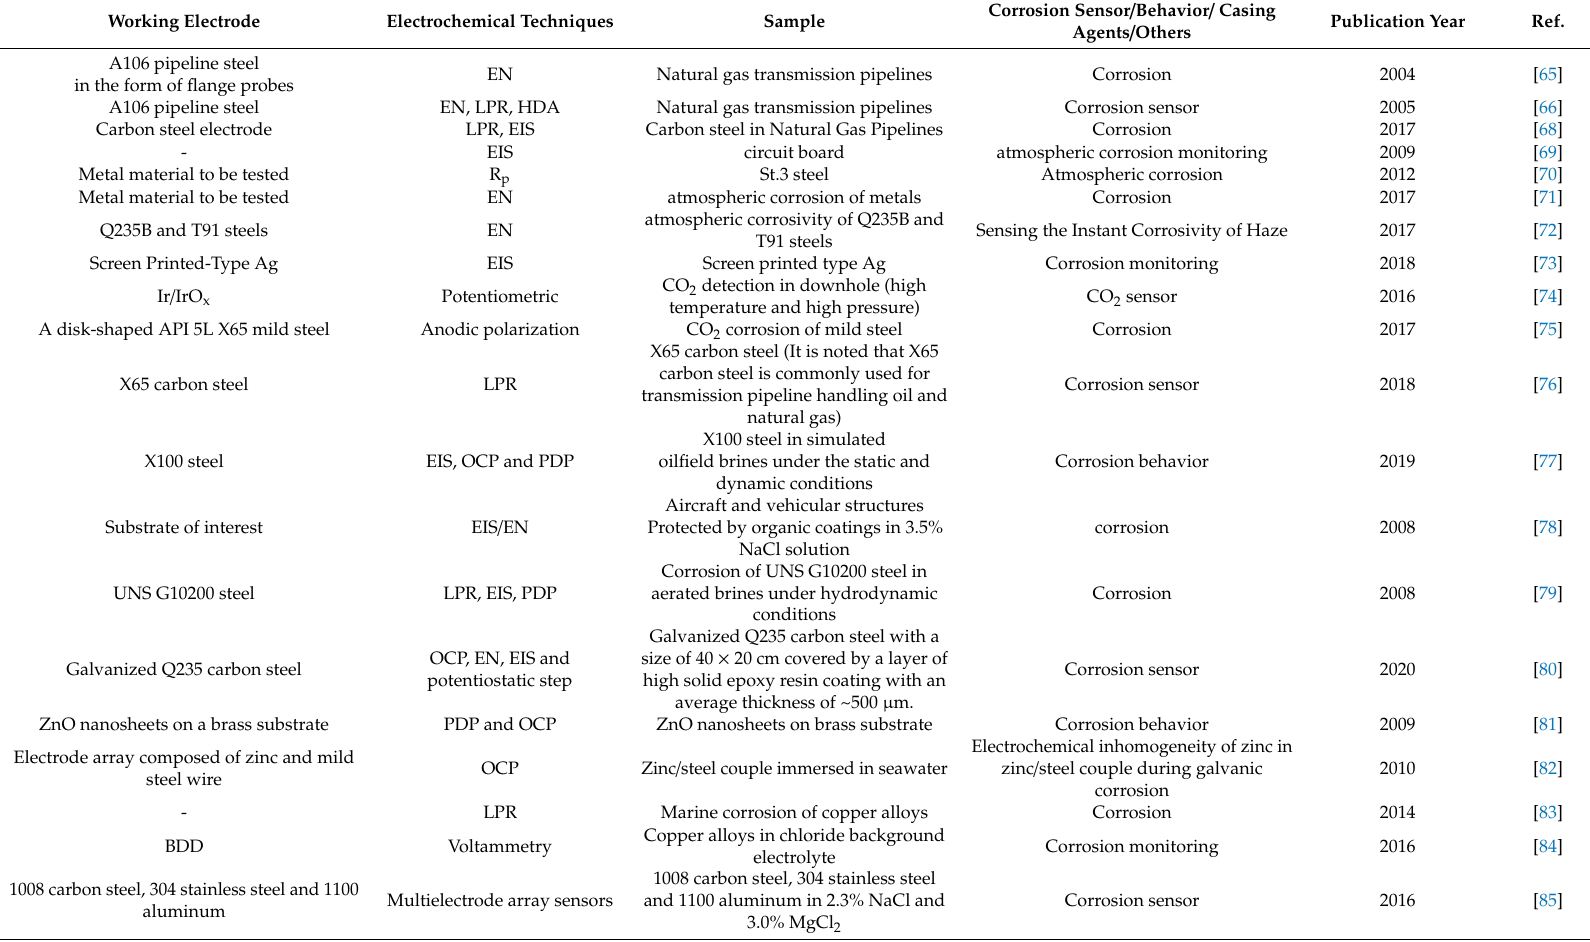
Table 2. Corrosion monitoring in natural gas transmission pipeline, atmosphere, CO 2 and marine